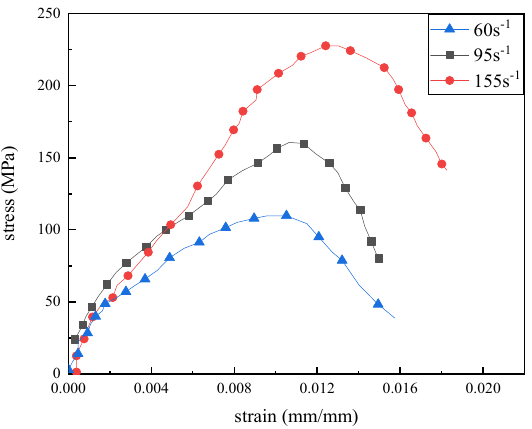
Figure 8. Dynamic stress–strain curves of sandstone at di ff erent strain rates.